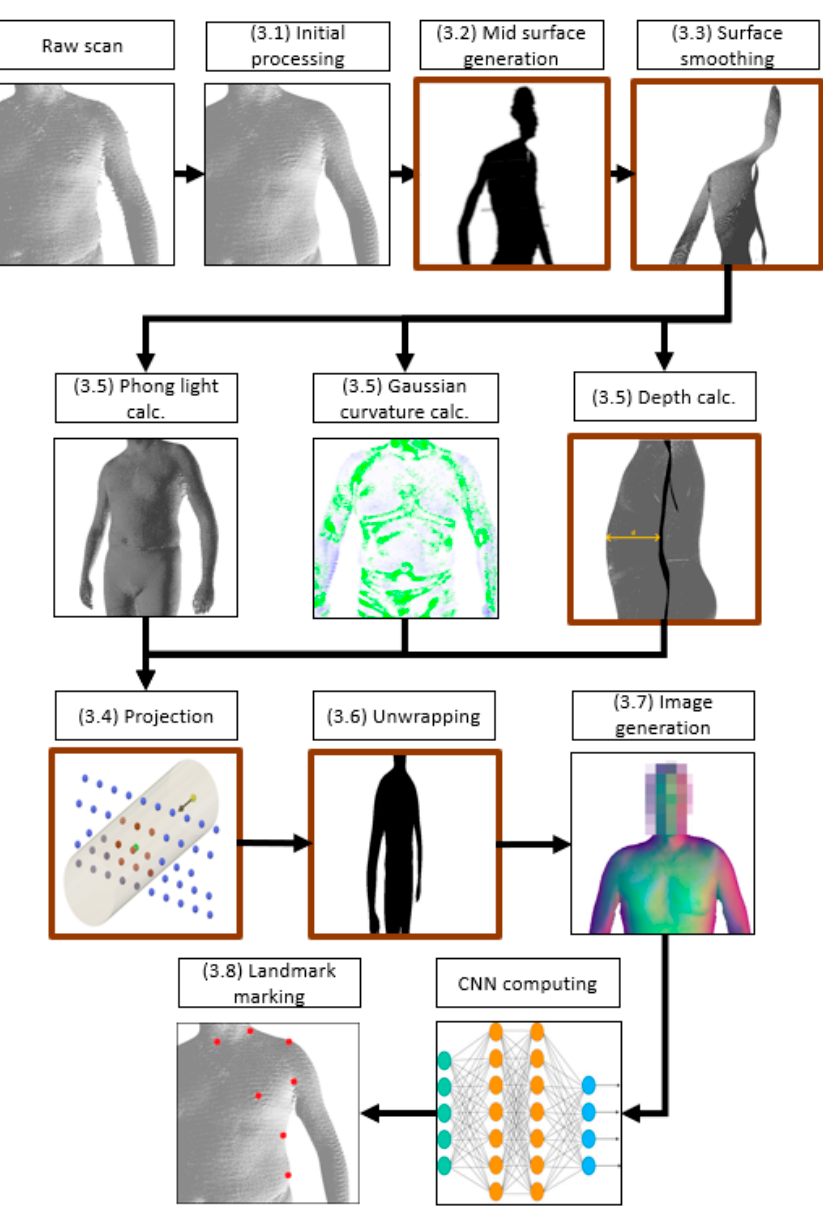
Figure 4. Workflow of mid-surface projection method. Bold brown frames represent steps, which di ff ered from our approach compared to the orthogonal projection approach.